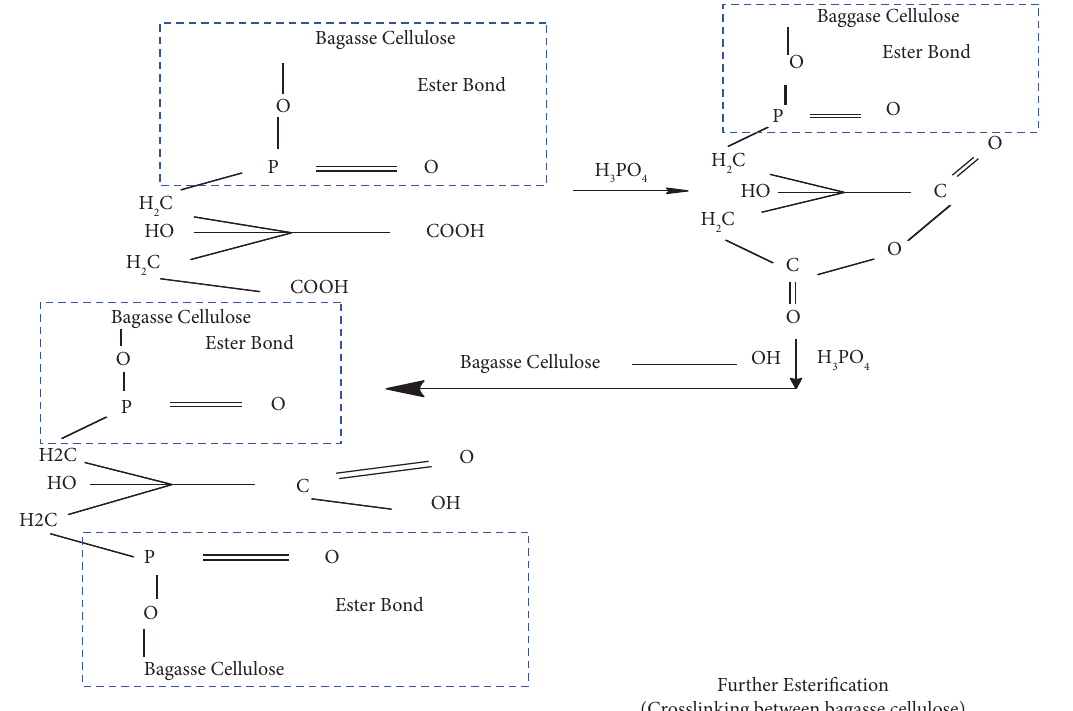
Figure 4: Further esterifcation reaction between cross-linking and